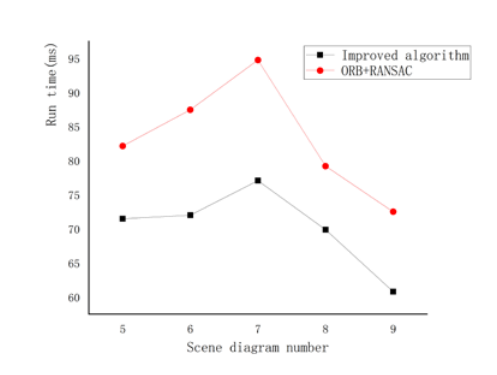
Fig. 1. Run time line graph of algorithm.